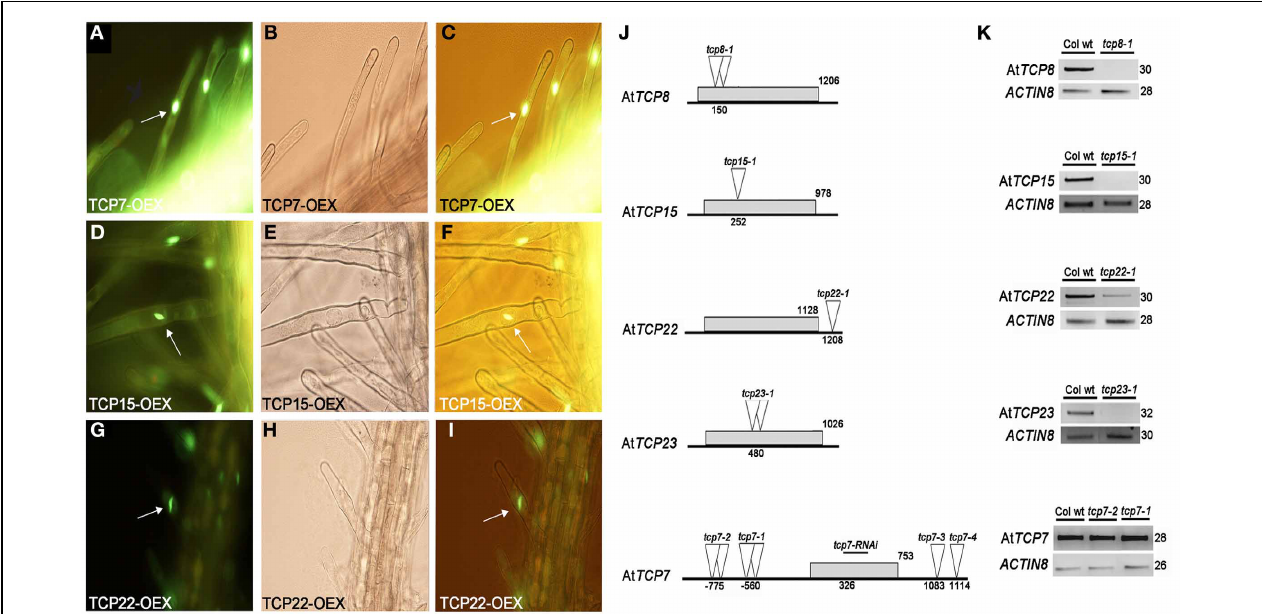
FIGURE 3 | Subcellular localization of class I TCP factors in root hair cells and characterization of class I TCP alleles . (A–C) AtTCP7, (D–F) AtTCP15, (G–I) AtTCP22. (A,D,G) The GFP signal is located at the nuclei (B,E,H) Bright-field images. (C,F,I) Merged images. Arrows indicate nuclear location. (J) Scheme of the genes and position of the insertions. Gray boxes indicate the coding sequence of the genes.